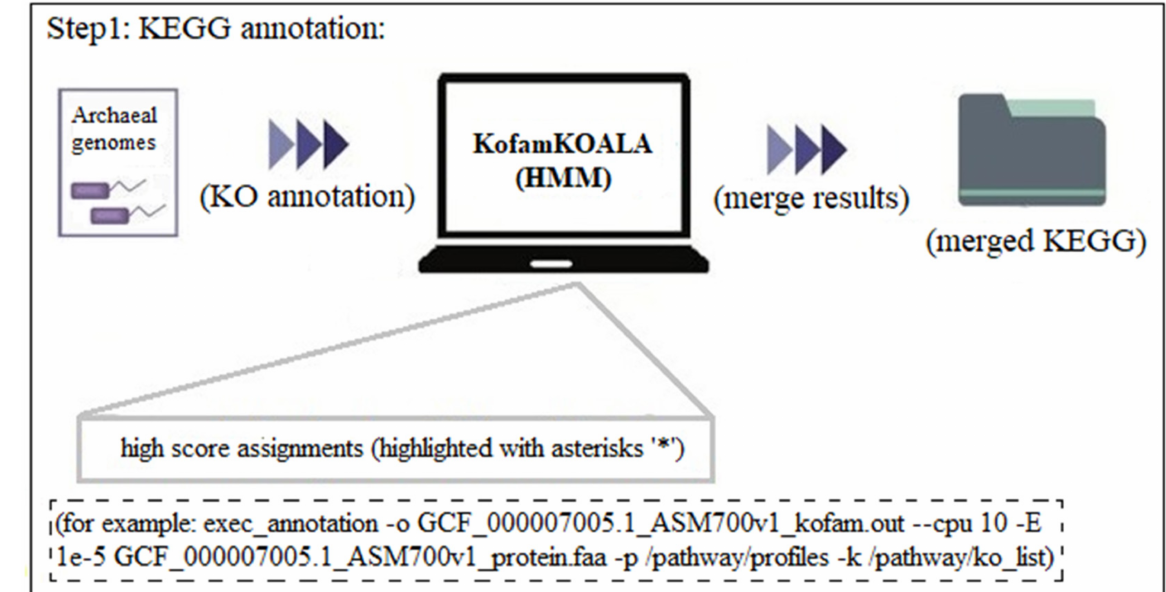
Figure 2. Step 1 of the usage and applications: KEGG